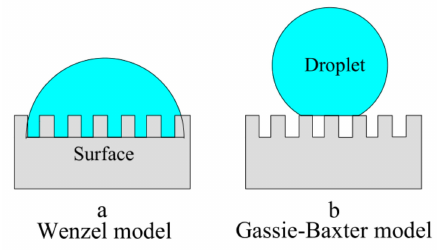
Figure 6. Wenzel and Cassie-Baxter model